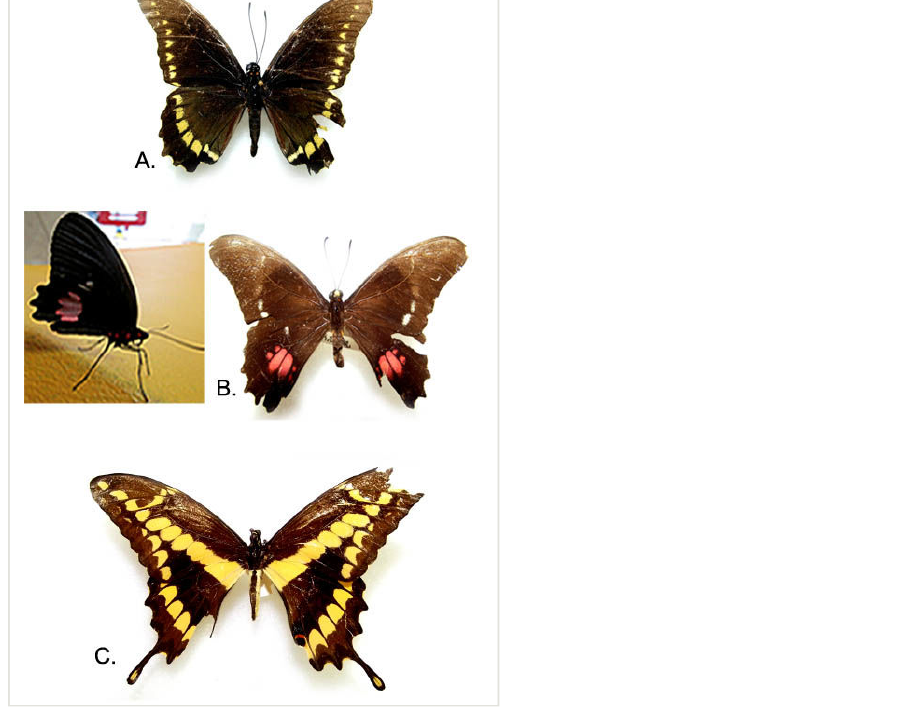
Figure 2. Papilionidae: A) Battus polydamas ; B) Parides anchisiades ; C) Heraclides rumiko